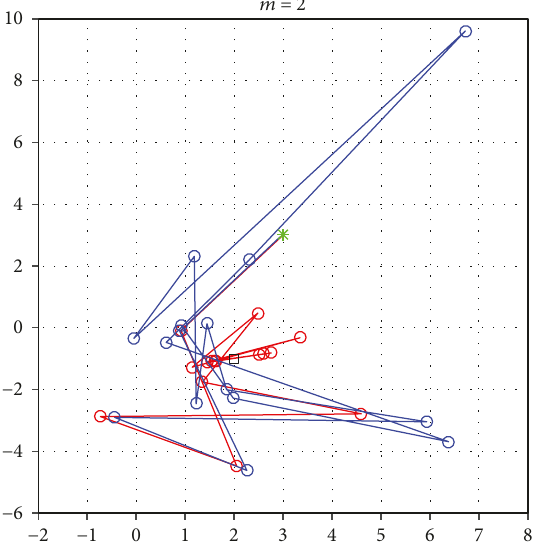
Figure 4: Newton paths generated from slightly di ff erent initial points near (3, 3) (marked with an asterisk): both eventually join again at the target point (2, − 1) (marked with a